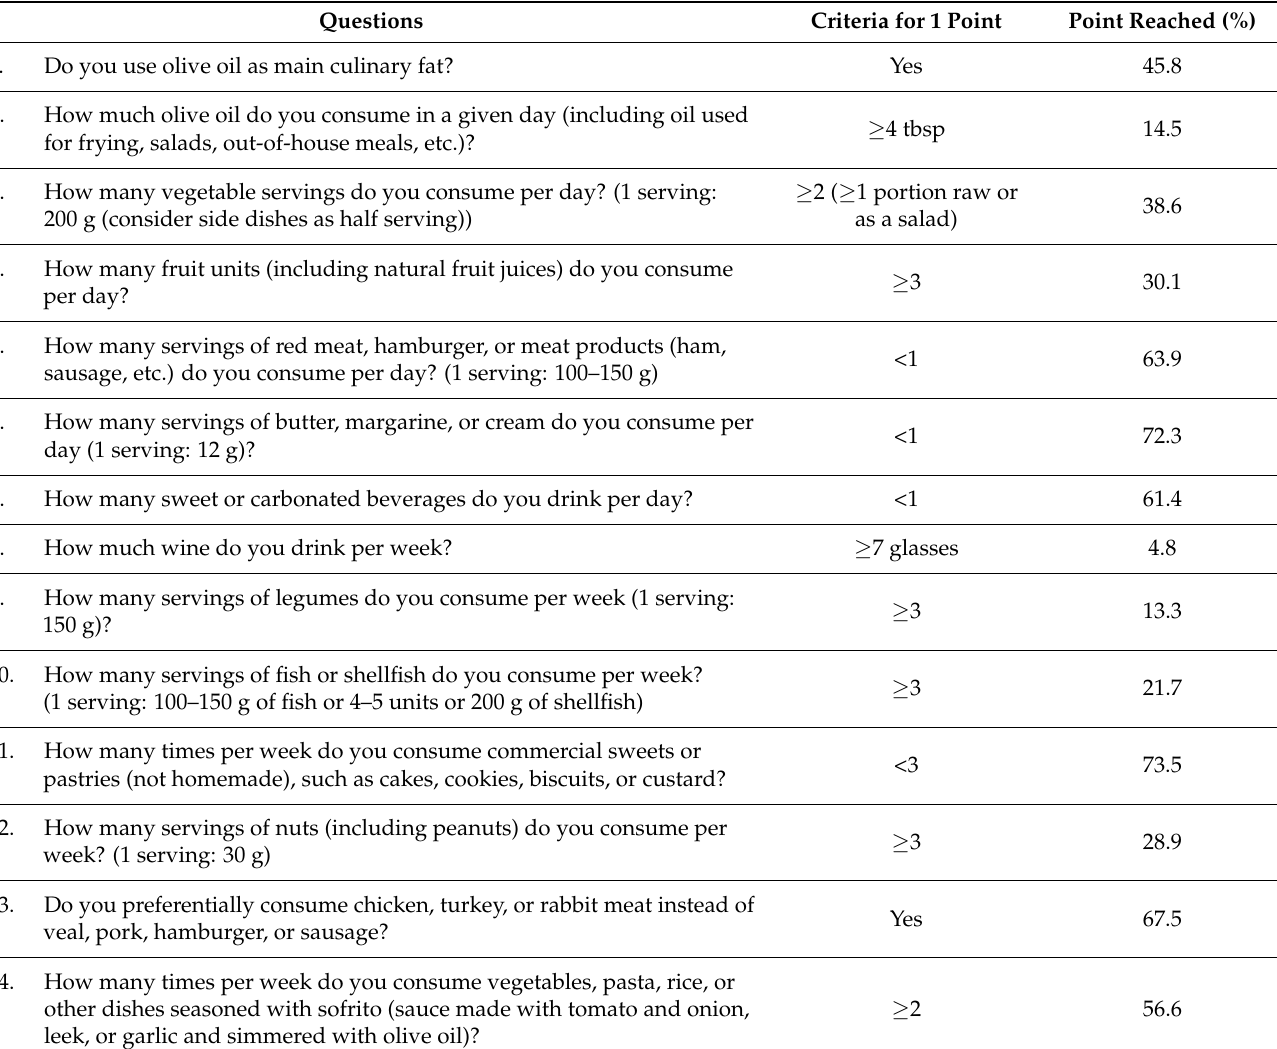
Table 3. Adherence to the Mediterranean diet among participating Turner syndrome